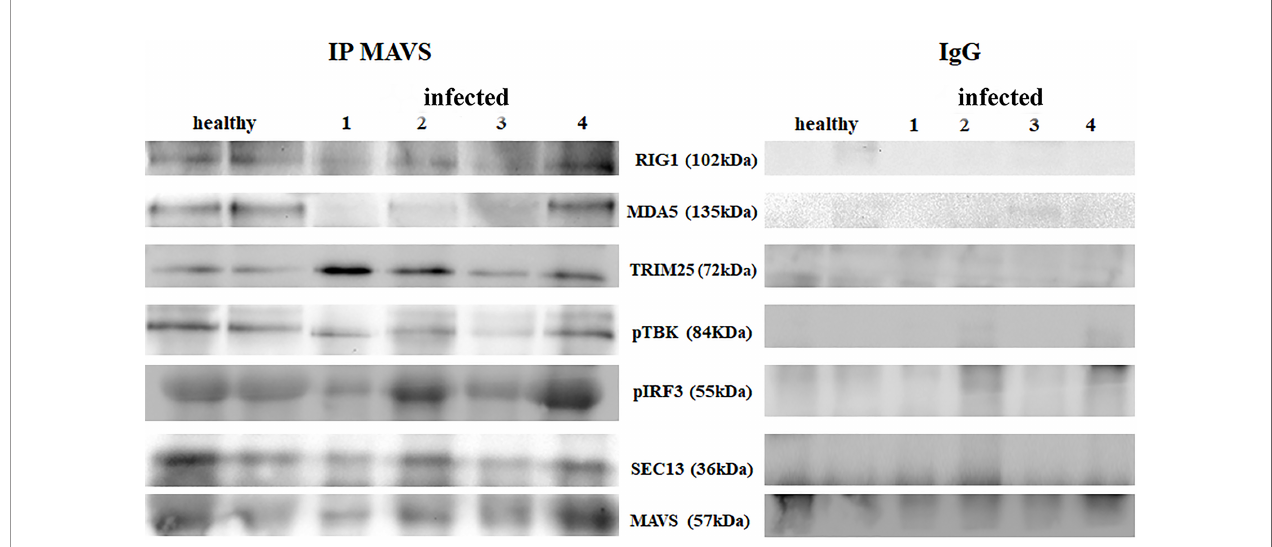
FIGURE 4 | Immunoprecipitation using an anti-MAVS antibody in healthy and diseased bladder samples. Western blot analysis revealed that MAVS interacted with RIG-I, MDA5, TRIM25, phosphorylated TBK1 (pTBK1), phosphorylated IRF3 (pIRF3) and Sec13. Immunoprecipitation panel showed representative data from three independent